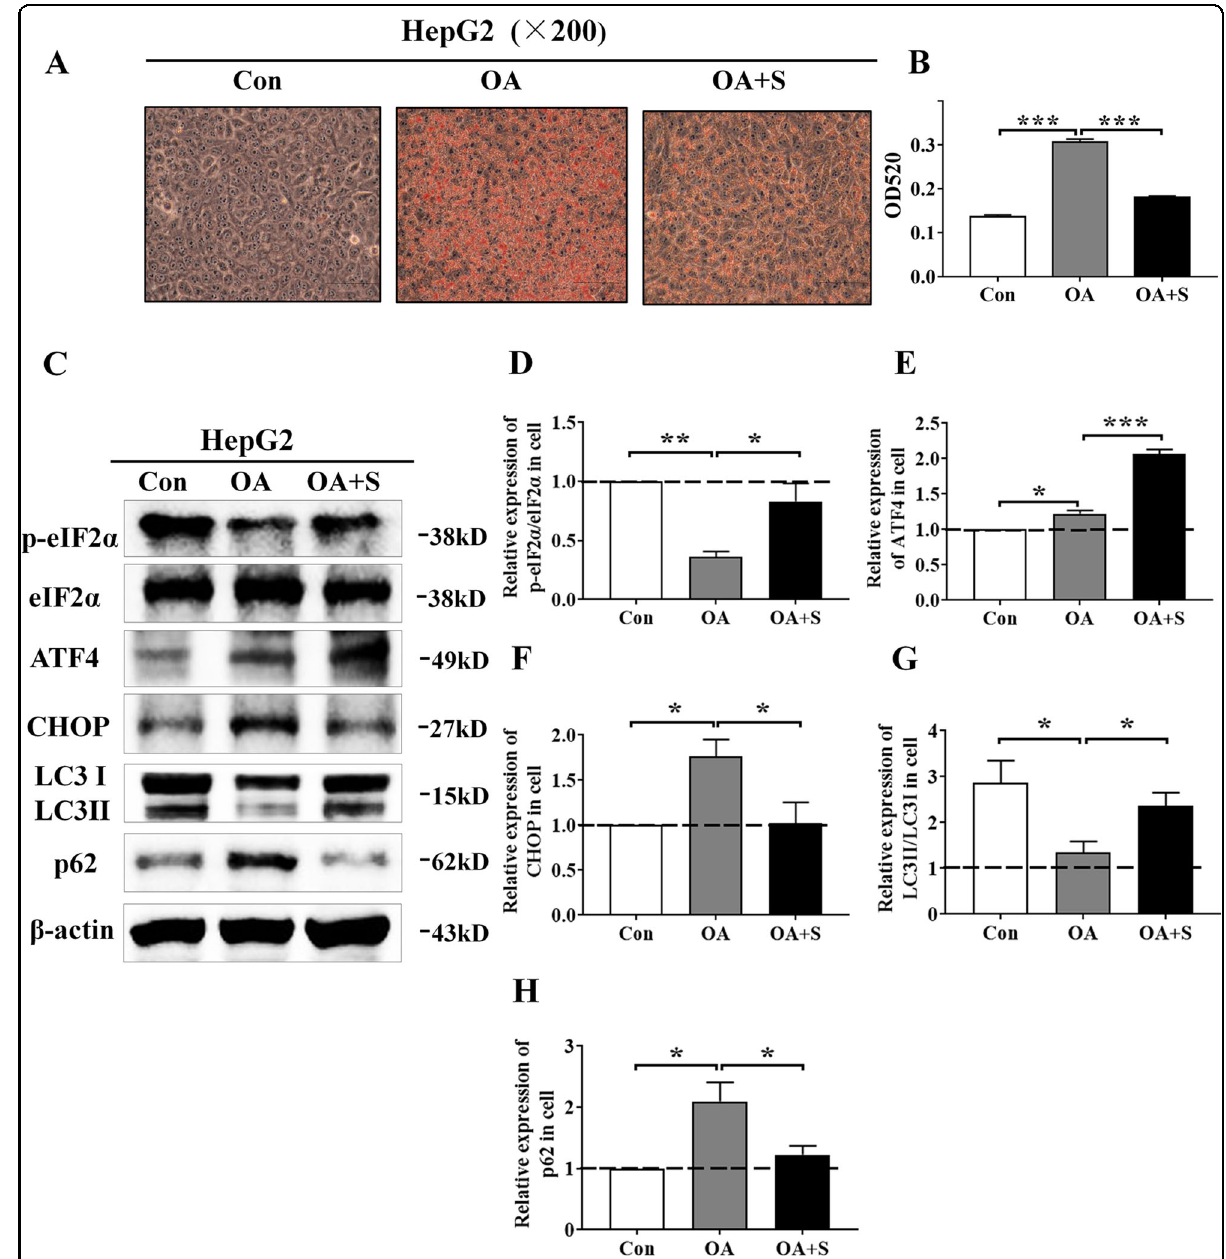
Fig. 5 Salubrinal impeded fatty degeneration in HepG2 cells. a, b Representative oil red O staining images showing salubrinal effects in HepG2 cells and quantitative analysis by OD 520 (200×; scale bar = 100 μ m; all graphics were processed in a blinded fashion). c Representative images of Western blot for the selected genes involved in the ER stress in HepG2 cells (p-eIF2 α , ATF4, and CHOP) and autophagy (LC3 and p62). d – h Relative intensities of p-eIF2 α /eIF2 α ( d ), ATF4 ( e ), CHOP ( f ), LC3II/I ( g ), and p62 ( h ). The experiments were conducted in triplicate. The asterisks (*, **, and ***) represent P < 0.05, P < 0.01, and P < 0.001, respectively (S: salubrinal and OA: oleic